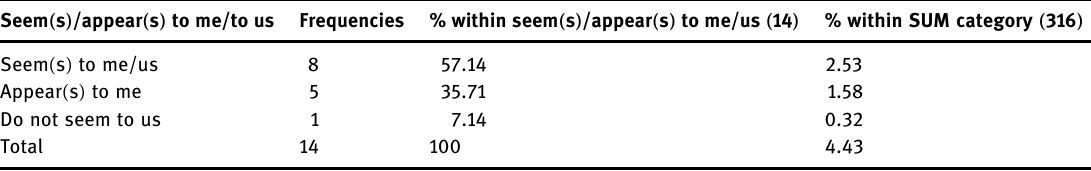
Table 12: Frequencies and percentages of the verbs “ seem ( s ) to me/us ” and “ appear ( s ) to me/us ” in the whole corpus Seem ( s ) /appear ( s ) to me/to us Frequencies % within seem ( s ) /appear ( s ) to me/us ( 14 ) % within SUM category ( 316 ) Seem ( s ) to